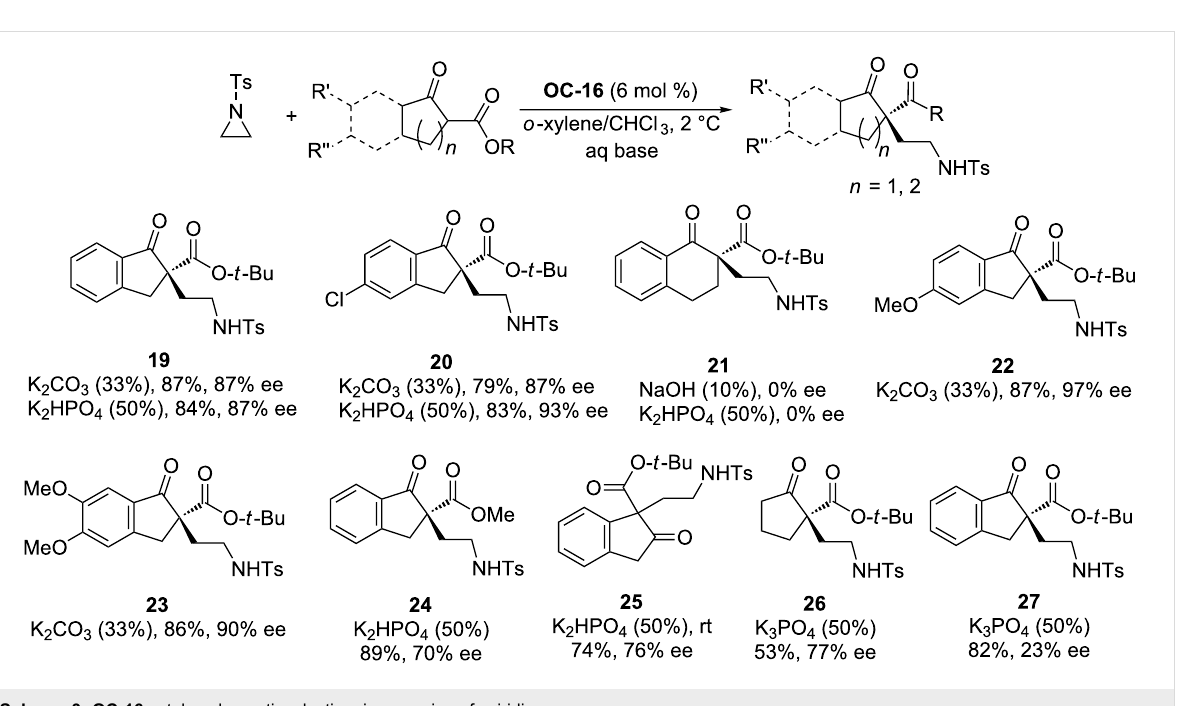
Scheme 3: OC-16 catalyzed enantioselective ring-opening of